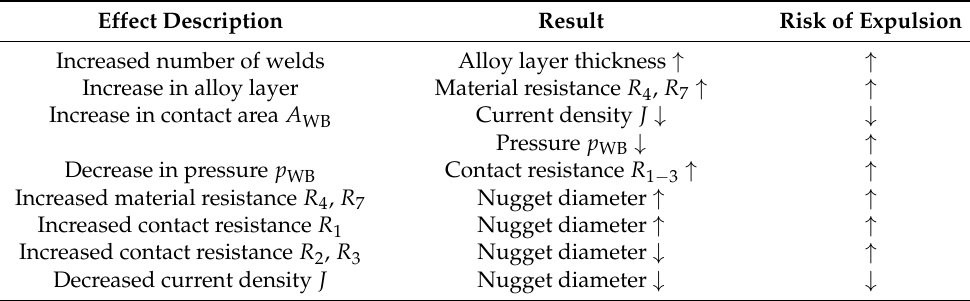
Table 3. Interlocking effects of mushrooming at resistance spot welding